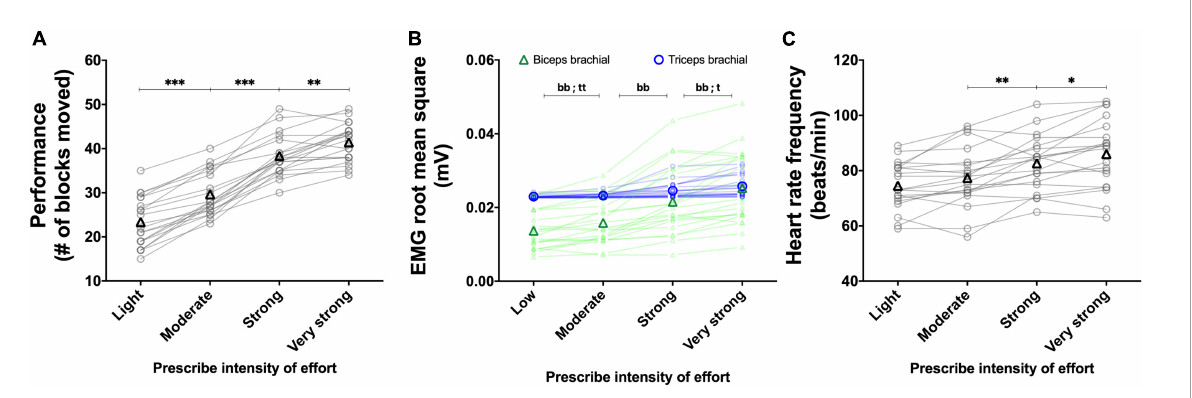
FIGURE9 Experiment 2A: Using the perception of effort to prescribe the exercise during the box and block test. Effect of increasing the prescribed intensity of effort on performance ( A , n = 20), EMG root mean square of the biceps (green line) and triceps (blue line) brachial muscles ( B , n = 20), heart rate frequency ( C , n = 20) during the box and block test. The exercise was prescribed at four intensities of perceived effort via the CR100 scale: light (13/100), moderate (23/100), strong (50/100), and very strong (70/100). Data are presented as the main effect of effort intensity, except for panel (B) presenting the effort intensity × muscle interaction. Individual data are presented in light markers and means in dark markers. *Main effect of difficulty, the difference between two difficulty levels. b and t are the difference between two difficulty levels for the biceps and triceps brachial muscles, respectively. One symbol: p < 0.05, two symbols: p < 0.01, and three symbols: p < 0.001.